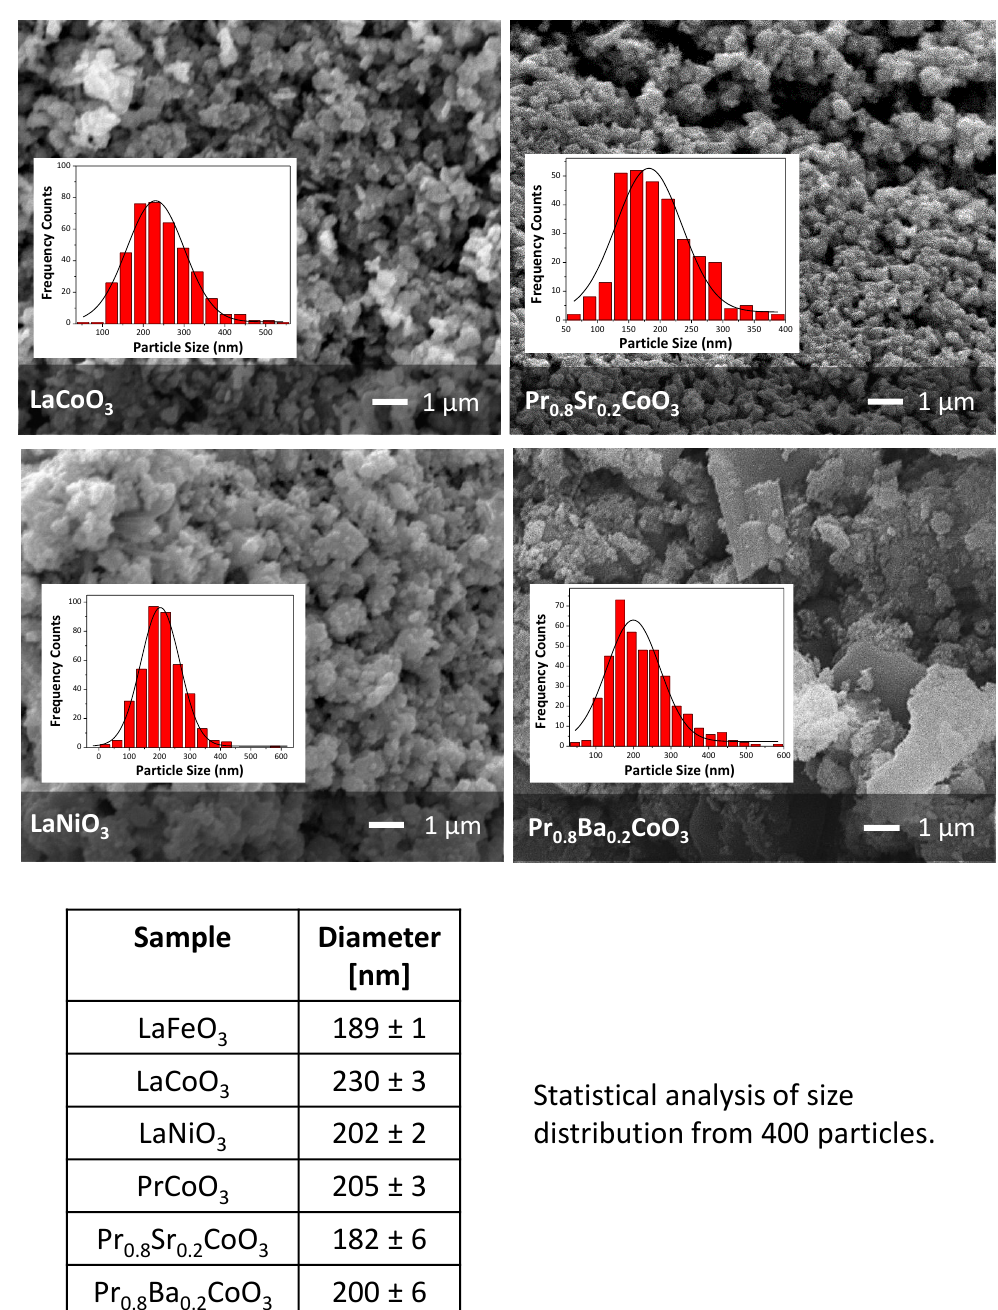
Figure 2. SEM images depicting the surface morphologies and particle size distribution of the prepared La- and Pr-based